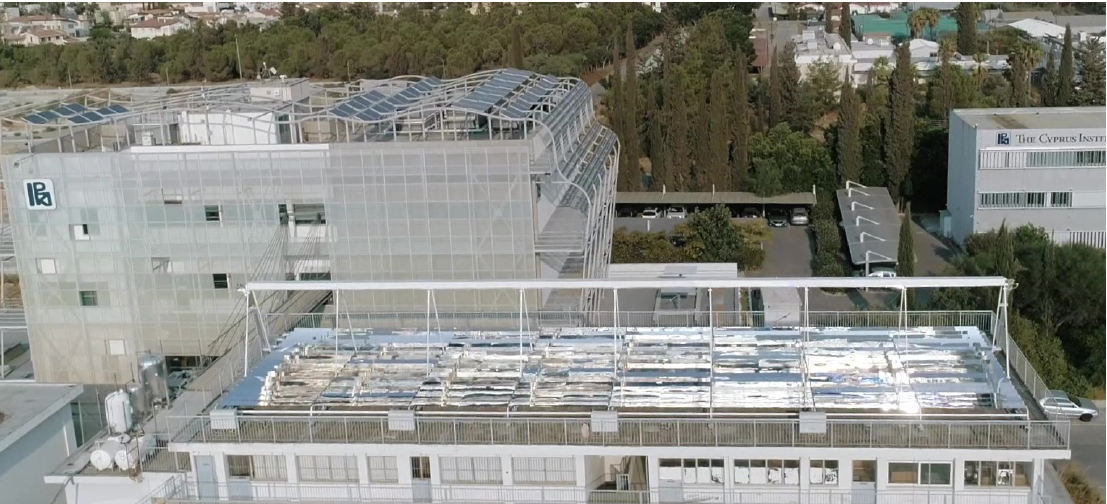
Figure 1. LFR collector at the Cyprus Institute and Novel Technologies Laboratory (NTL) building in the background on the